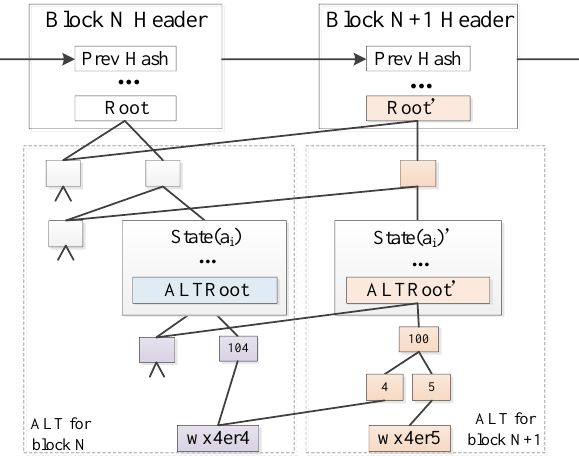
Figure 2. Schematic Diagram of ALT Storage